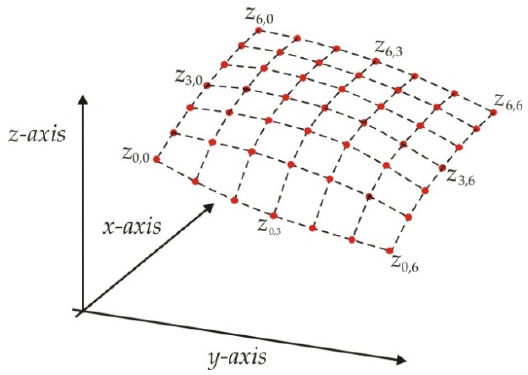
Figure 1. Free-form surface data to perform surface modeling.